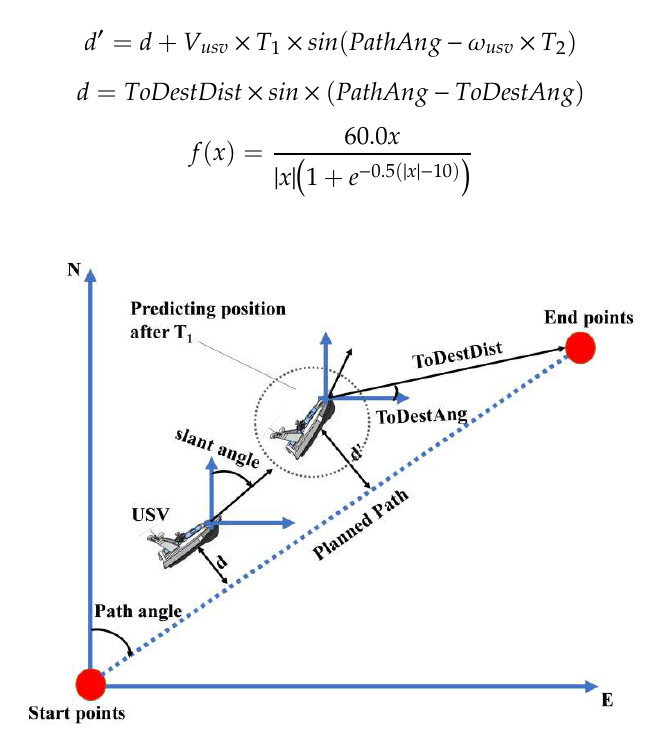
Figure 5. Path-following algorithm based on predicted position control.